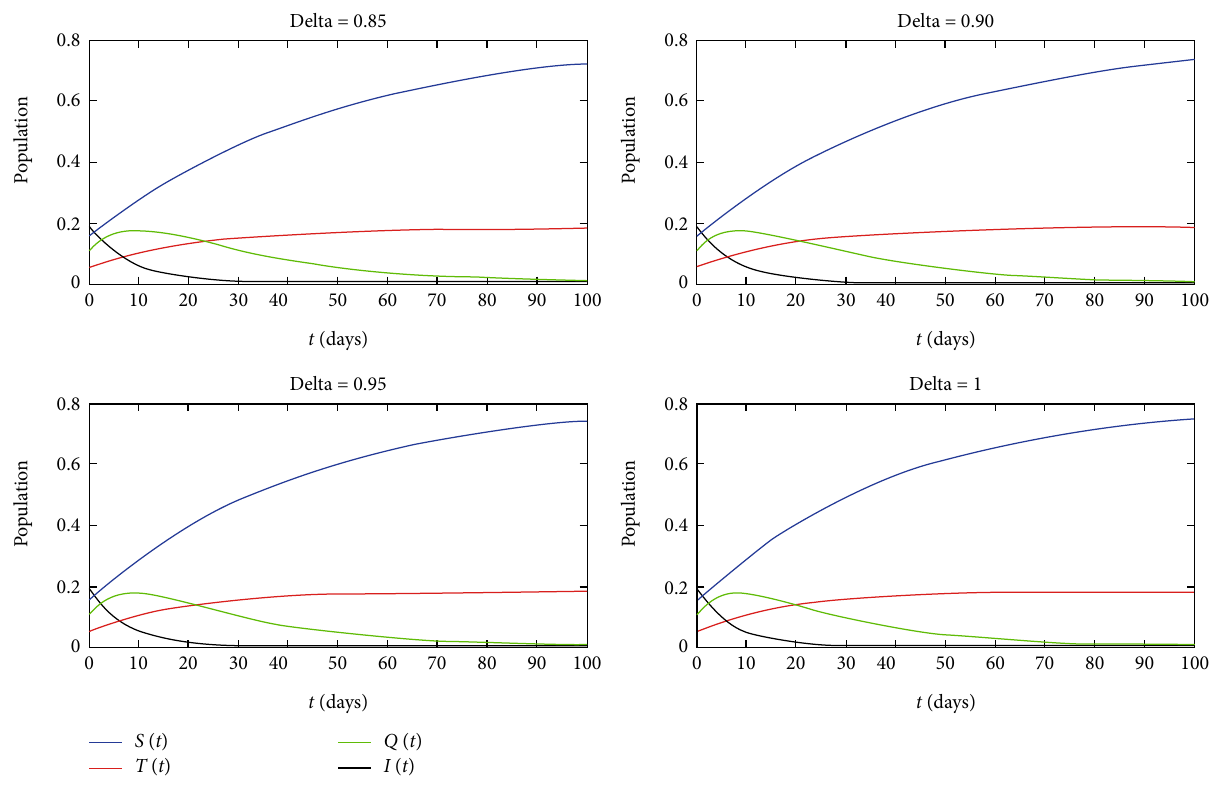
Figure 2: Time series plot of all variables for distinct values of δ :